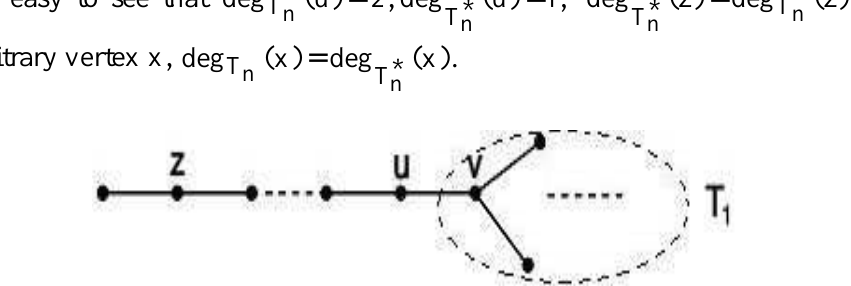
Figure 1 . The Chemical Tree T